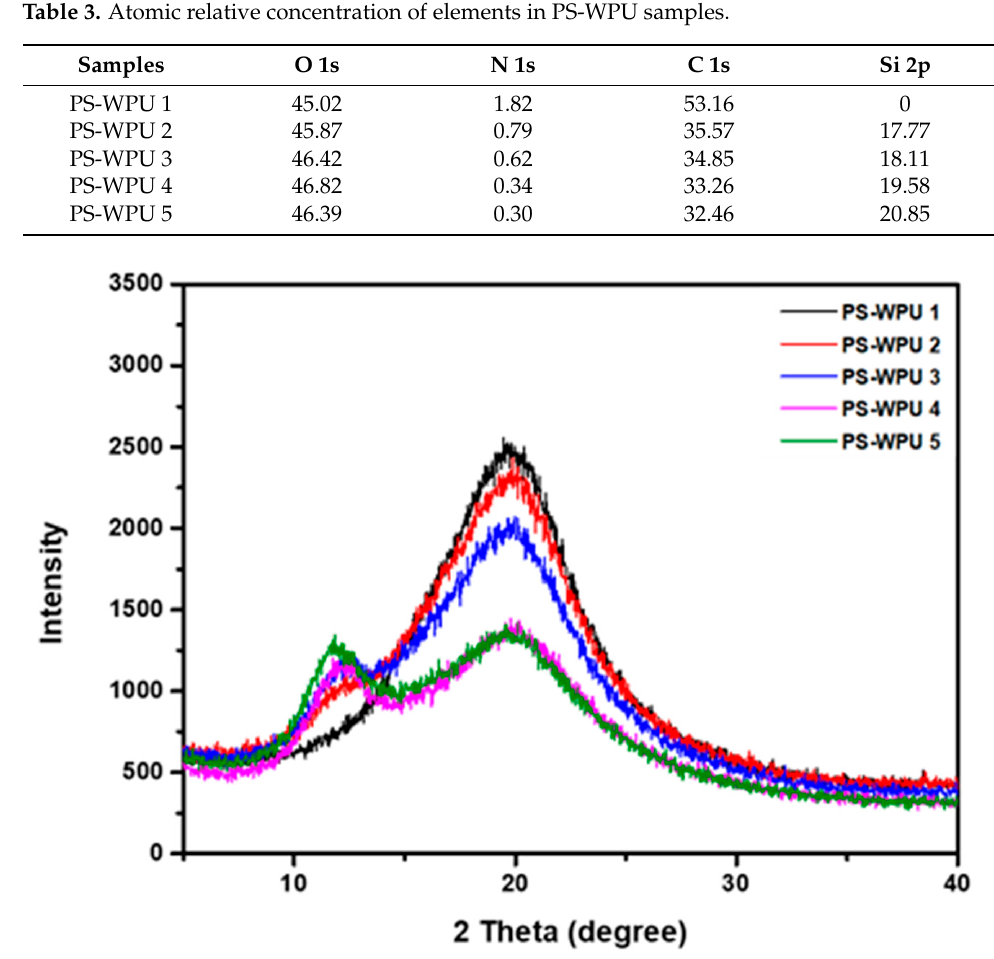
Figure 4. X-ray diffraction patterns of PS-WPU Figure 3. X-ray diffraction patterns of PS-WPU samples.